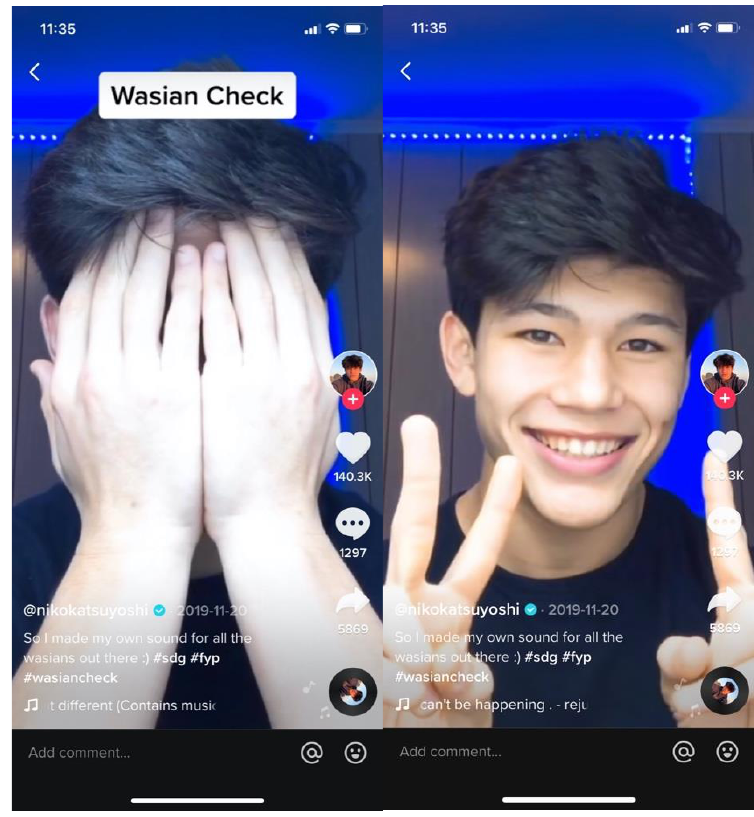
Figure 1. #wasian check face reveal.